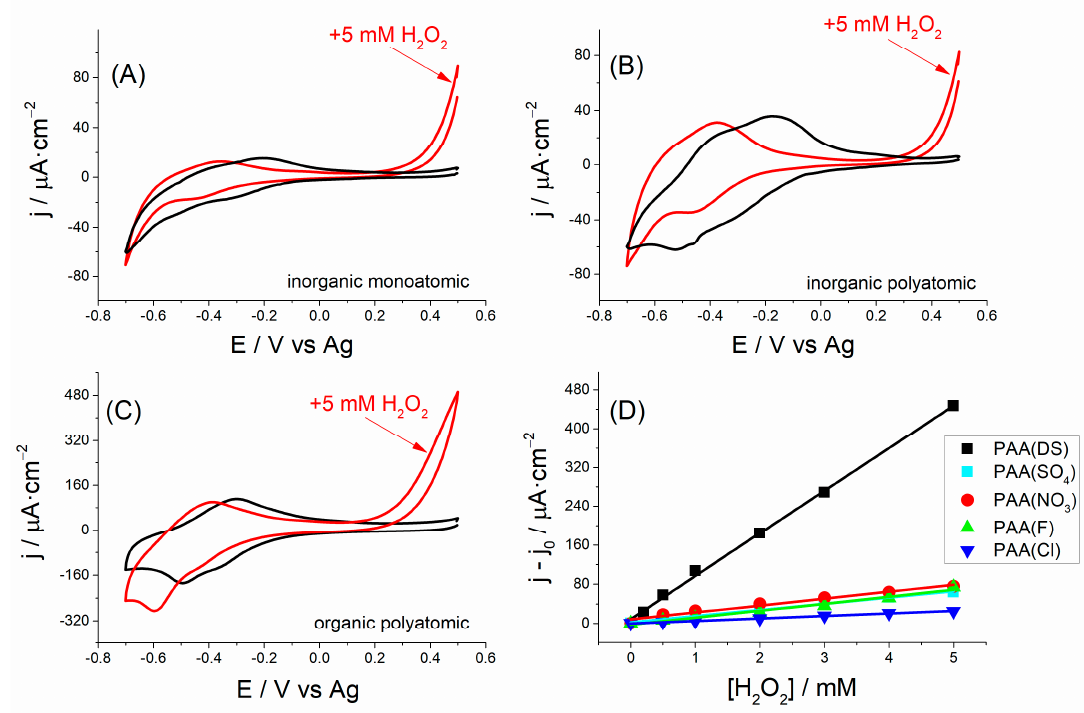
Figure 5. Cyclic voltammograms (scan rate: 10 mV · s − 1 , 0.1 M phosphate buffer (pH 7)) of different PAA(anion) films in the absence (black lines) and presence of 5 mM H 2 O 2 (red lines) for PAA(F), PAA(SO 4 ) and PAA(DS) films (( A – C ), respectively). ( D ) Current at 0.5 V vs. H 2 O 2 concentration for all modified SPCEs. Error bars correspond to three replicates for each modified electrode.